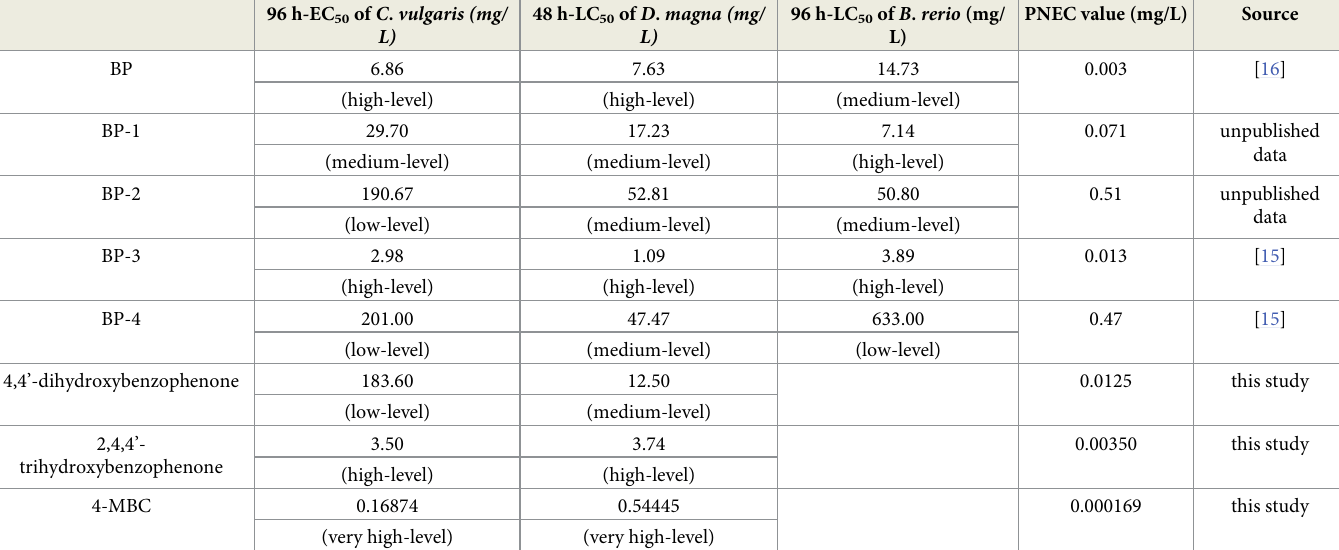
Table 4. Toxicity results of UV